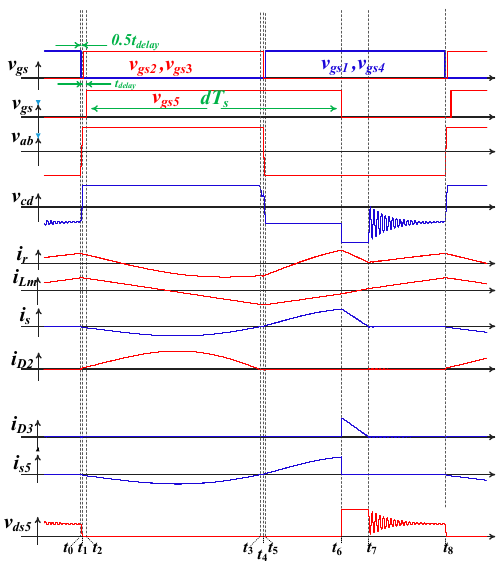
Figure 3. Operational Principle in PWM mode.